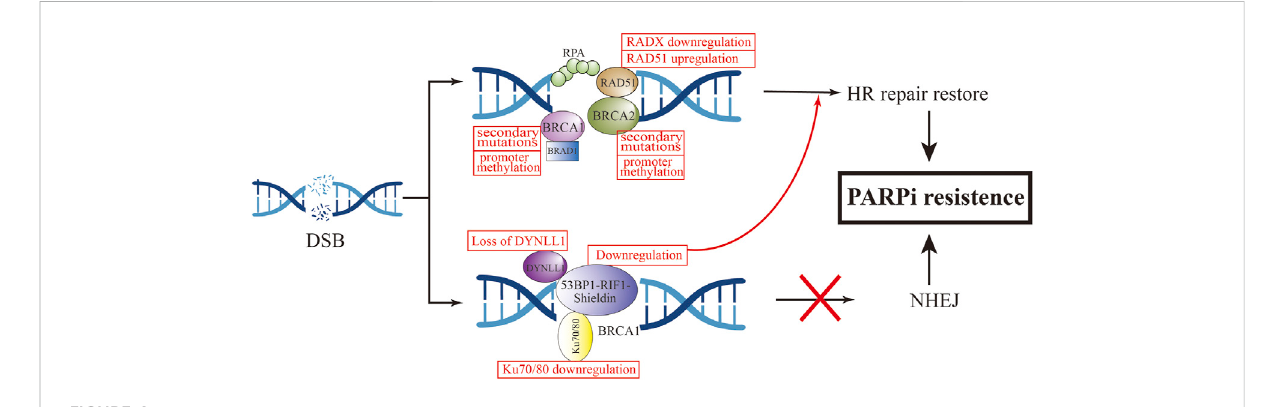
FIGURE 4 Mechanism of HR-dependent pathway leading to PARPi